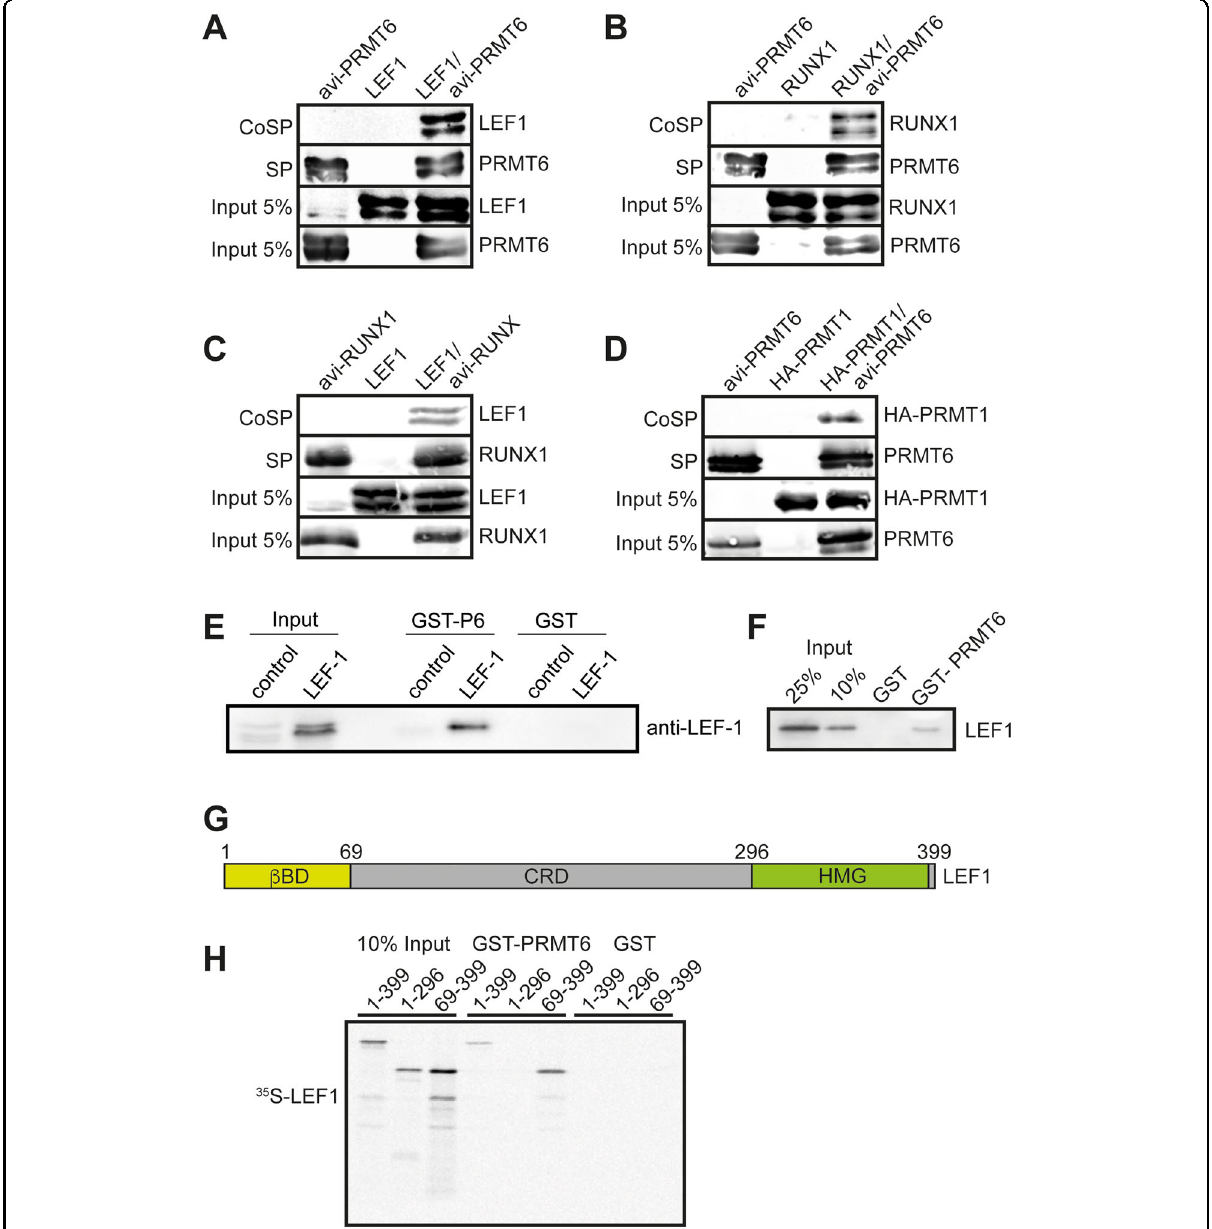
Fig. 3 LEF1 is a novel identi fi ed PRMT6 interaction partner. Co-streptavidin-precipitation (CoSP). The biotin tagged bait was co-transfected with the prey expression vector into HEK293 cells. The biotinylated bait was pulled out from extracts with streptavidin beads (SP). Coprecipitated bait protein is shown in the upper lane, (CoSP). A CoSP of PRMT6 and LEF1. Coprecipitation of LEF1 was detected with an anti-LEF1 antibody. B CoSP of PRMT6 and RUNX1. Coprecipitation of RUNX1 was detected with an anti-RUNX1 antibody . C CoSP of RUNX1 and LEF1. Biotinylated RUNX1 protein was pulled out from extracts with streptavidin beads. Coprecipitation of LEF1 was detected with an anti-LEF1 antibody. D CoSP of PRMT6 and PRMT1. Coprecipitation of PRMT1 was detected with an anti-HA antibody. E GST-pulldown with GST-PRMT6 as bait and LEF1 protein expressed in HEK293 cells. GST-PRMT6 was incubated with cell extracts of from LEF1 over expressing cells. GST-pulldown with GST protein served as negative control. The GST proteins were pulled out with glutathione beads. Pulled out LEF1 was detected by western blot with anti-LEF1 antibody. F GST-pulldown with GST-PRMT6 and in vitro translated LEF1. Pulled out LEF1 was detected by western blot with anti-LEF1 antibody. G Schematic representation of the LEF1 protein. H GST-pulldown with GST-PRMT6 and in vitro translated 35 S labeled LEF1 deletion constructs. GST protein served as negative control and the GST proteins were pulled out with glutathione beads. Detection of pulled out LEF1 protein was done by radiography.